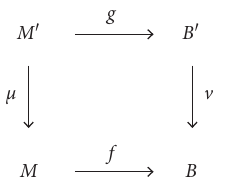
Figure 1: The Stein factorization for f is as